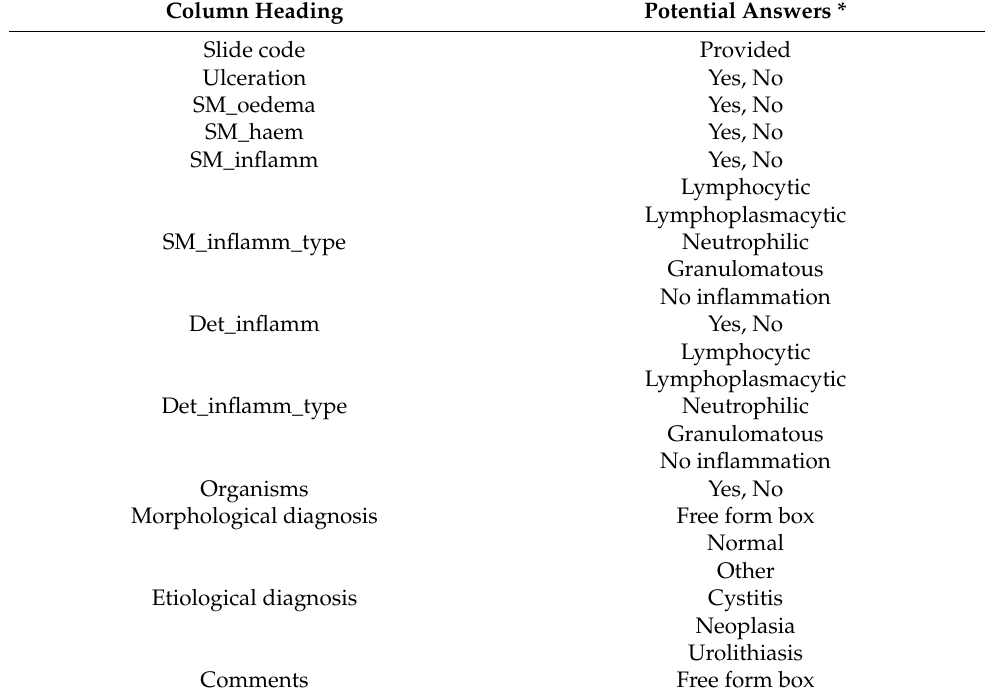
Figure 1. Sequence of assessment of the slide set by each pathologist. Table 1. Histological criteria to be assessed by the pathologists in worksheets one and two (without and with signalment and clinical history).